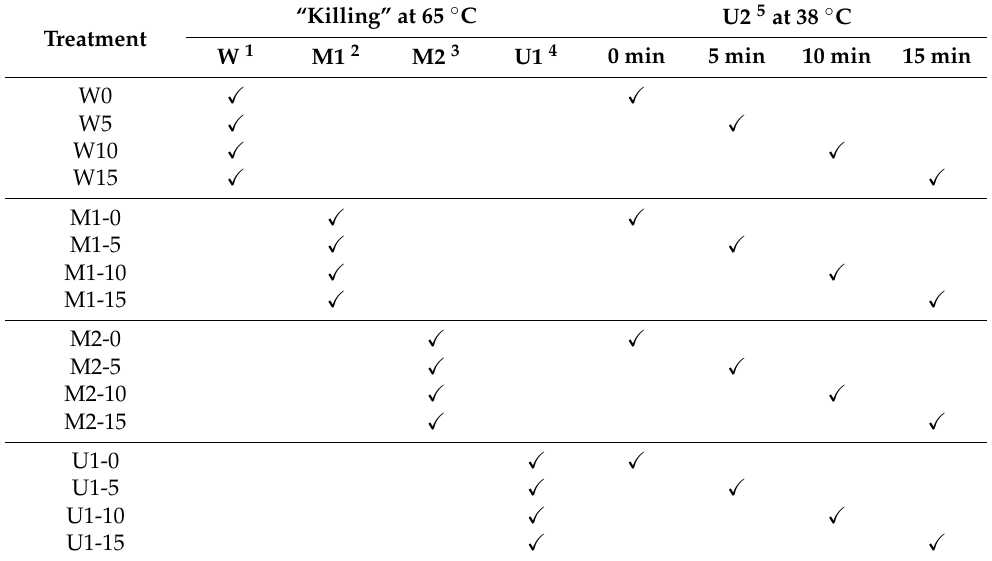
Table 1. Experiments analyzed during the CP.